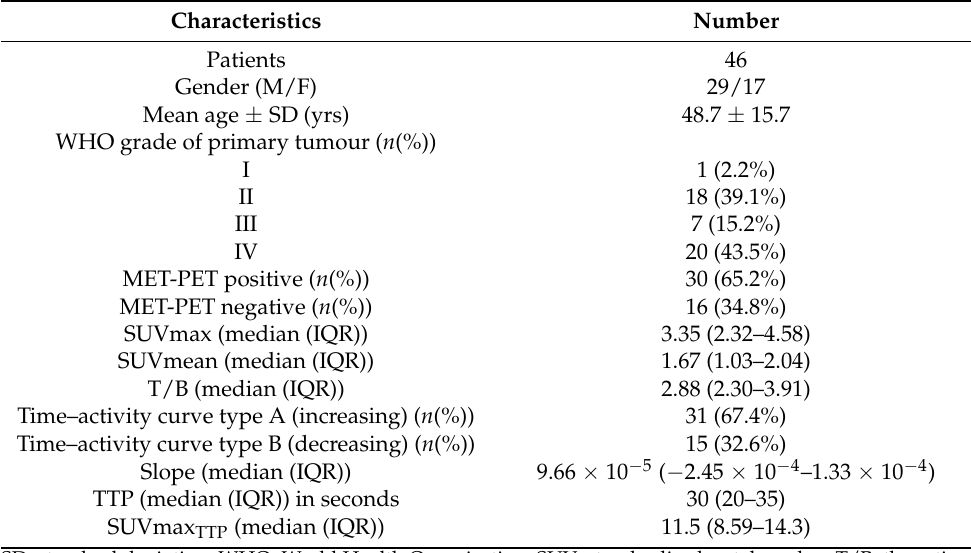
Table 4. Functional MET-PET parameters and main clinical characteristics of patients with dynamic acquisition ( n = 46).